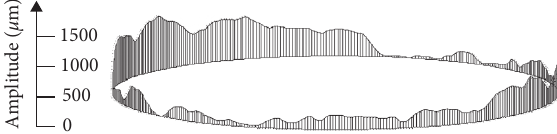
Figure 2: The example of the unevenness profile in a 34 m telescope azimuth track